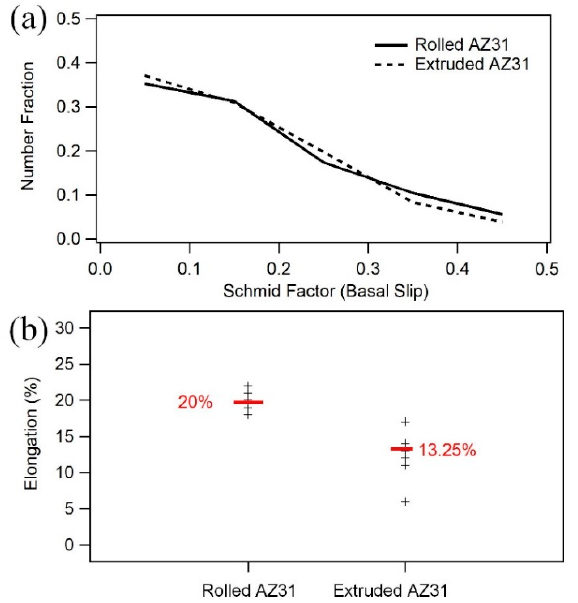
Figure 12. ( a ) Schmid factor distribution, and ( b ) elongation during tension tests of typical rolled AZ31 alloys and extruded alloys (data collected from the literature).